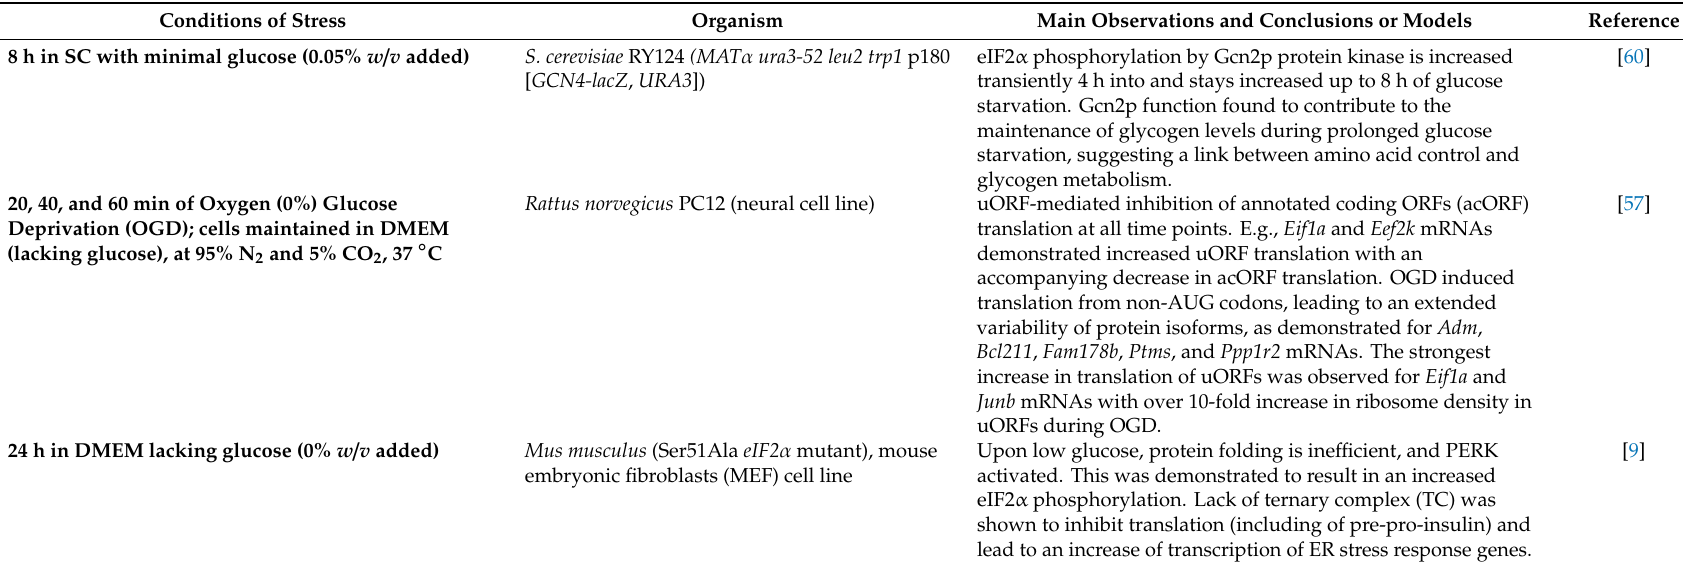
Table 4. Regulation by start codon recognition during glucose starvation